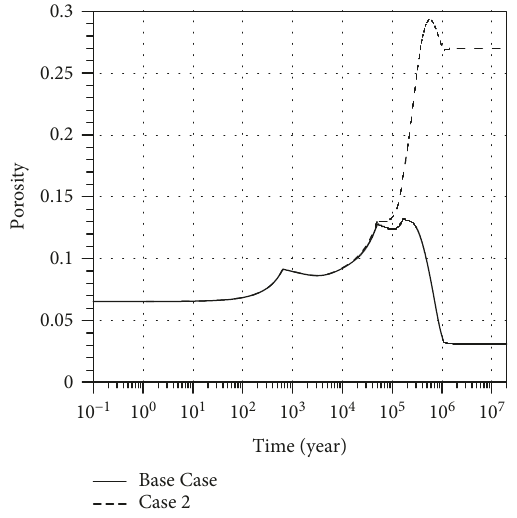
Figure 8: Variation in the porosity of the rock versus time obtained with (Case 2) and without (Base Case) considering the scour of